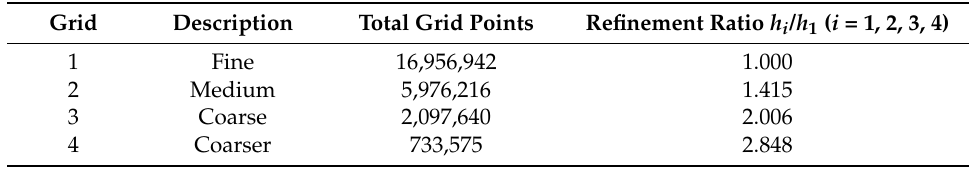
Table 1. Simulation parameters.